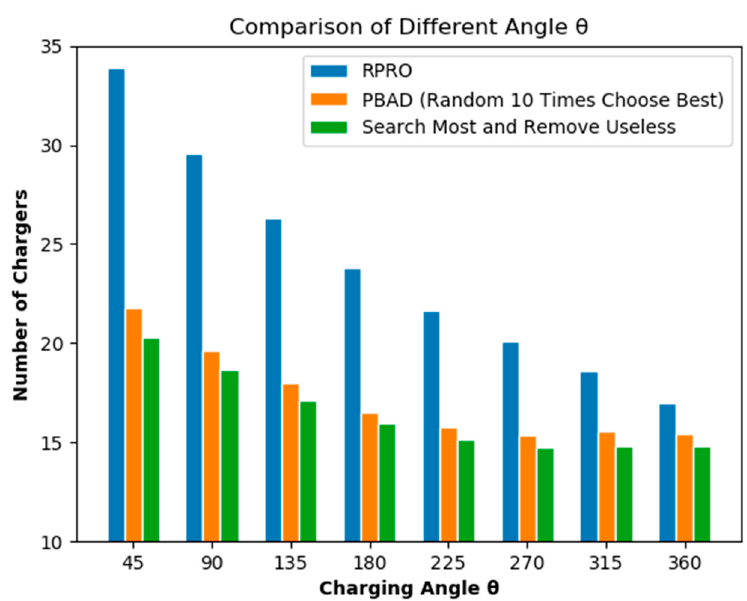
Figure 9. The comparison results of different charging angles.